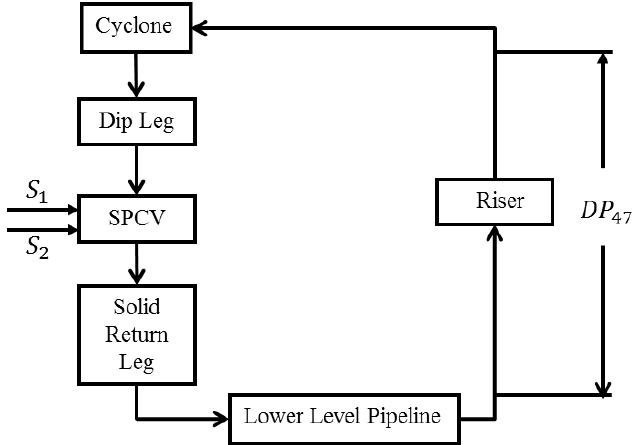
Figure 2. Block diagram for a single-loop cold flow CL test rig.